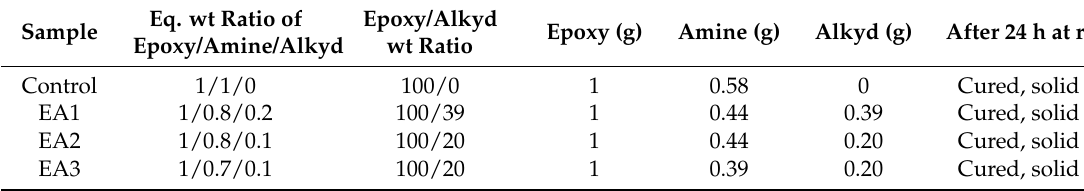
Table 5. Reactions of alkyd, epoxy and amine hardener in different